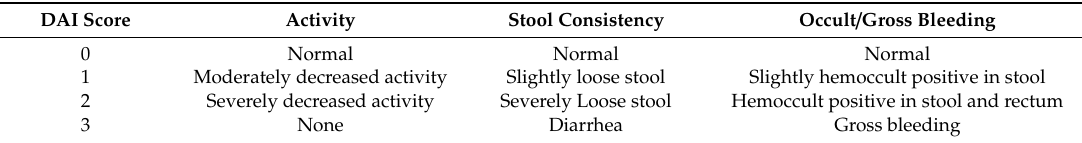
Table A1. Scoring of the disease activity index